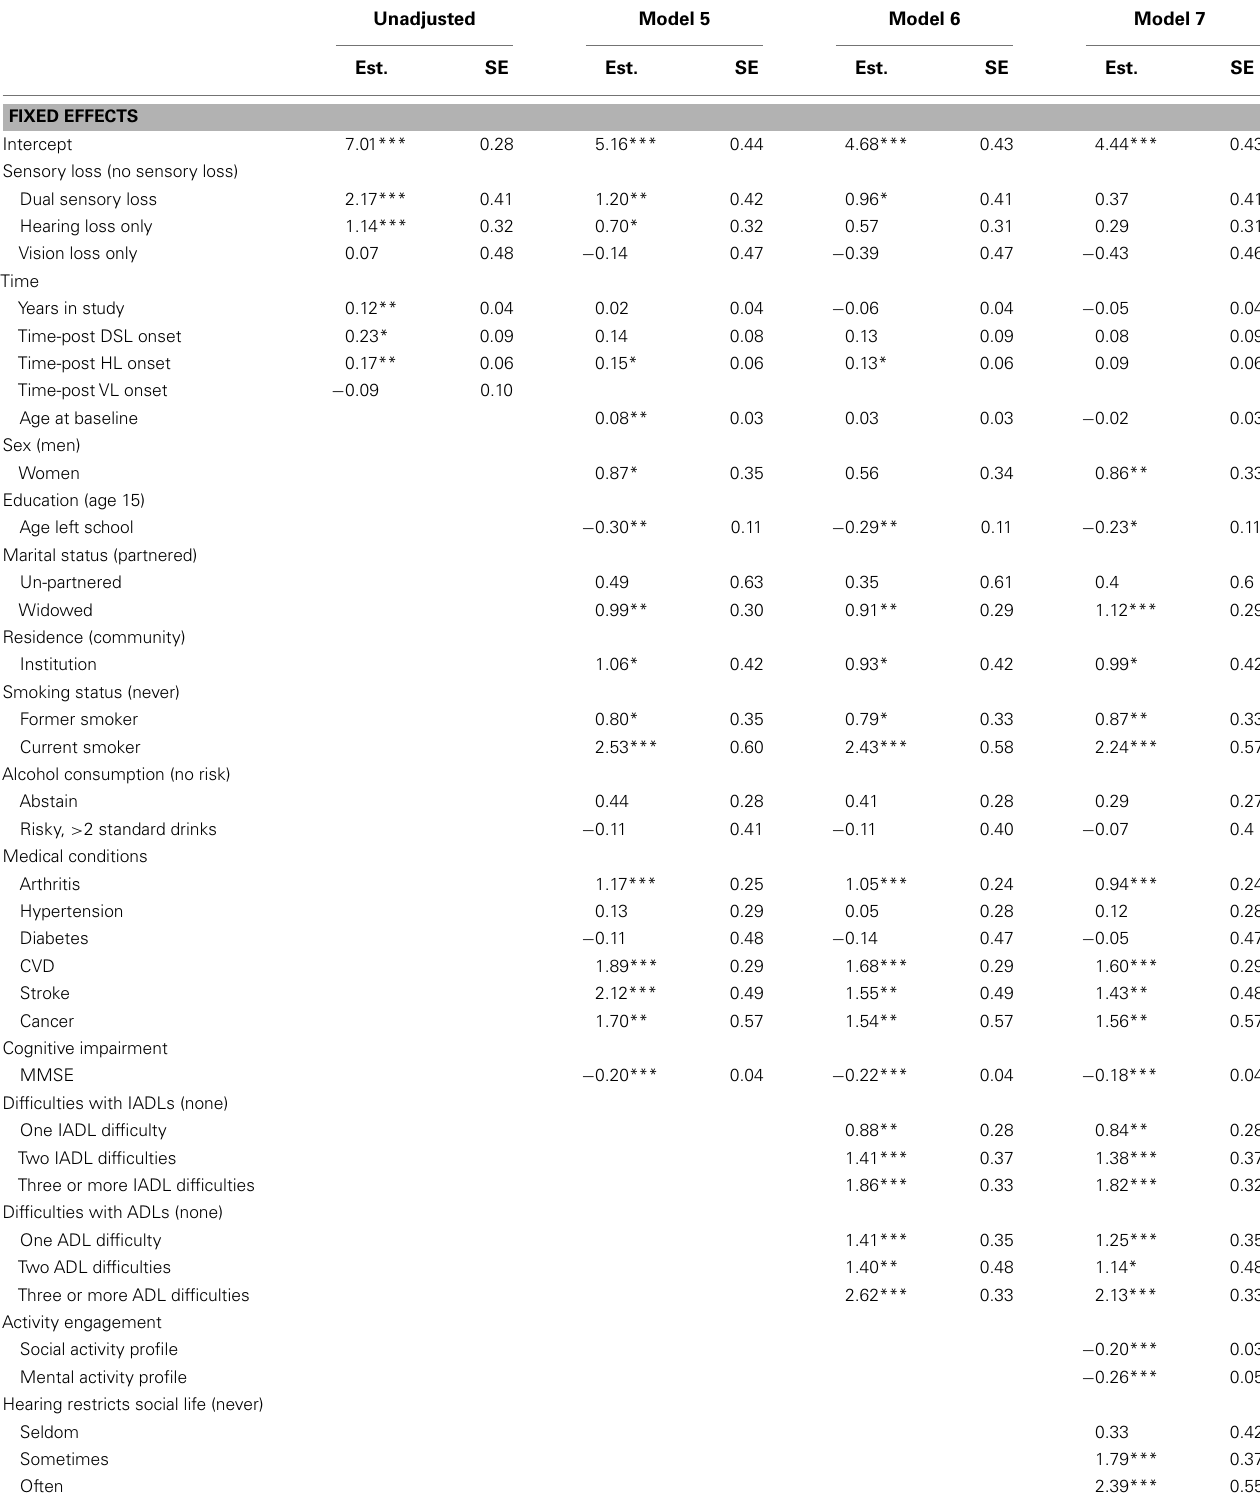
Table 5 | Parameter estimates from piecewise linear-mixed models testing predictors of CES-D score, from 20 multiply imputed datasets ( n = 1611)